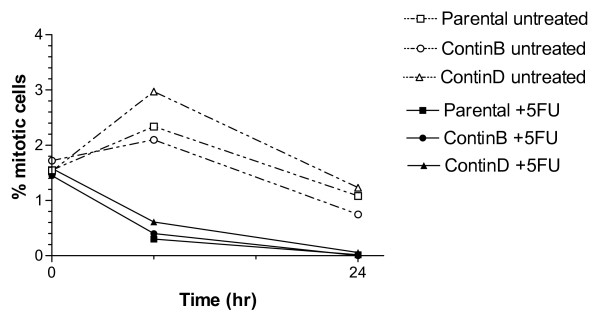
Mitotic fractions in parental and 5-FU-resistant HCT116 cell lines in response to 5-FU treatment for 24 hours: mitotic fractions in all cell lines at 8 and 24 hours after 5-FU addition, showing gradual cessation of mitosis over the 24-hour treatment period.